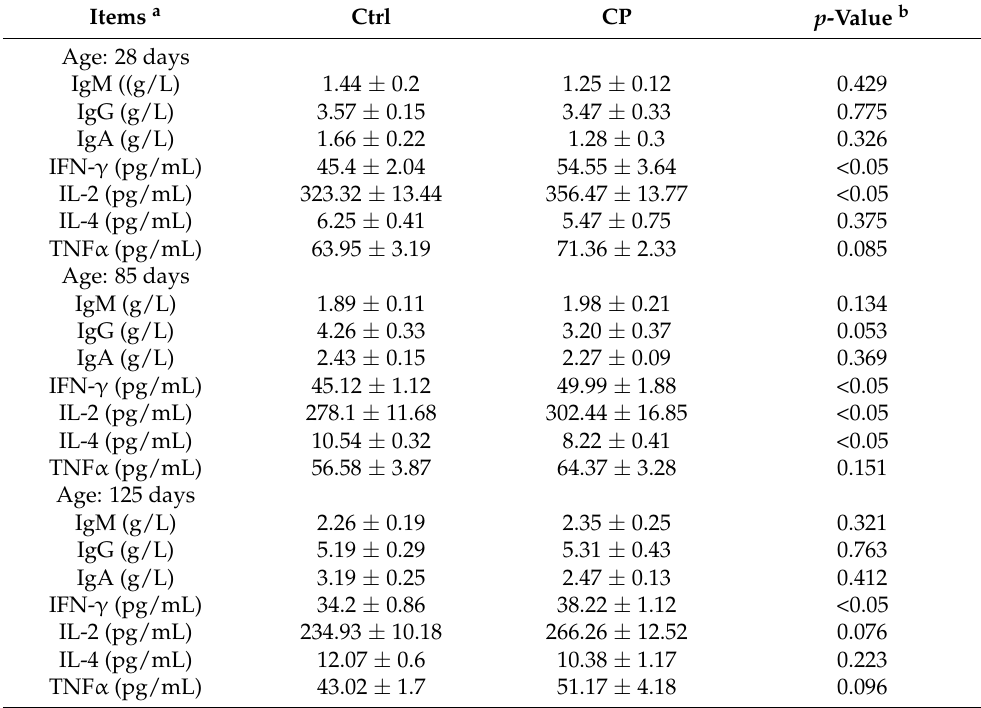
Table 4. Effects of compound probiotics on serum immune indices of